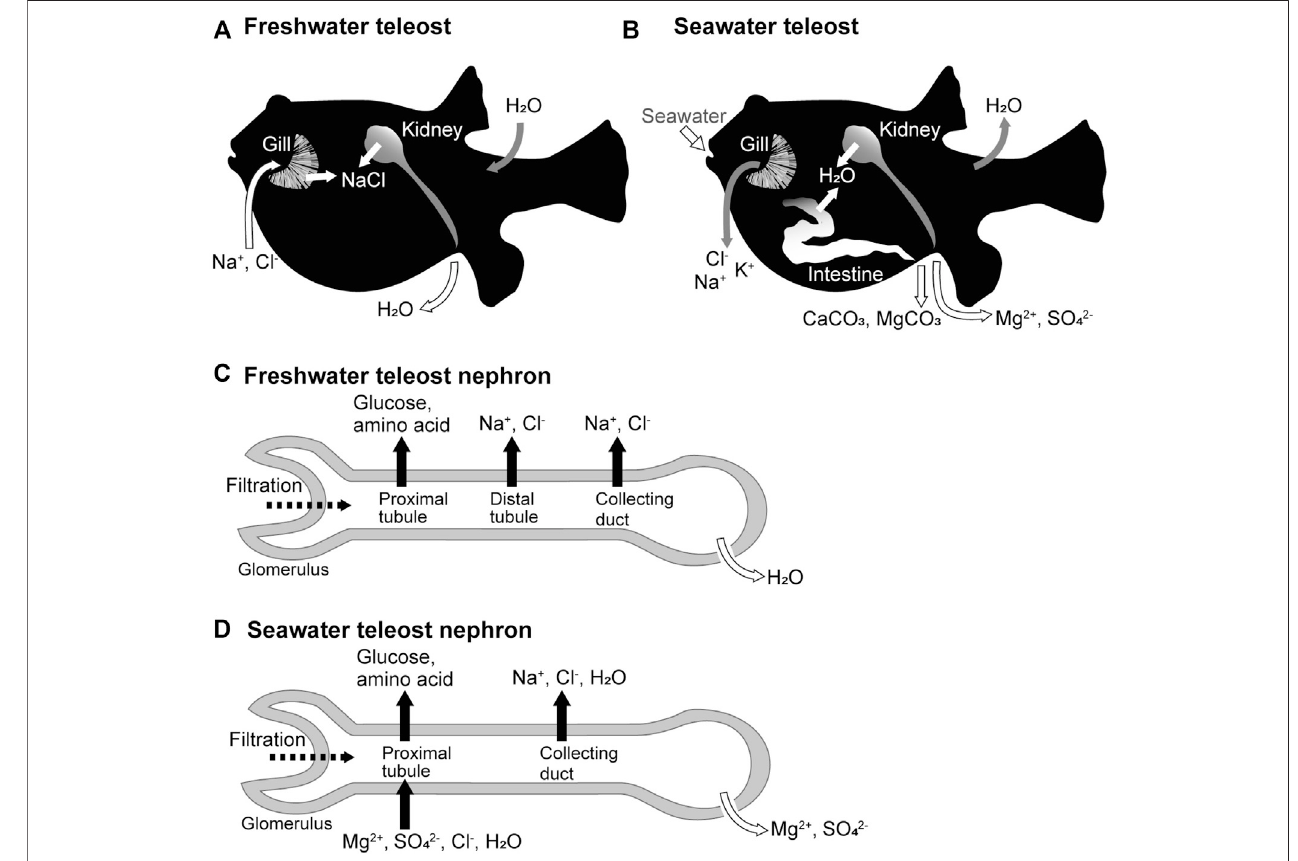
FIGURE 1 | Freshwater and seawater acclimations of teleost fi shes and organ functions. (A,B) Movement of ions and water across the epithelia of the gill, kidney, and intestine of freshwater and seawater teleosts. (C,D) Ion and water movement in the nephrons of freshwater and seawater teleosts.